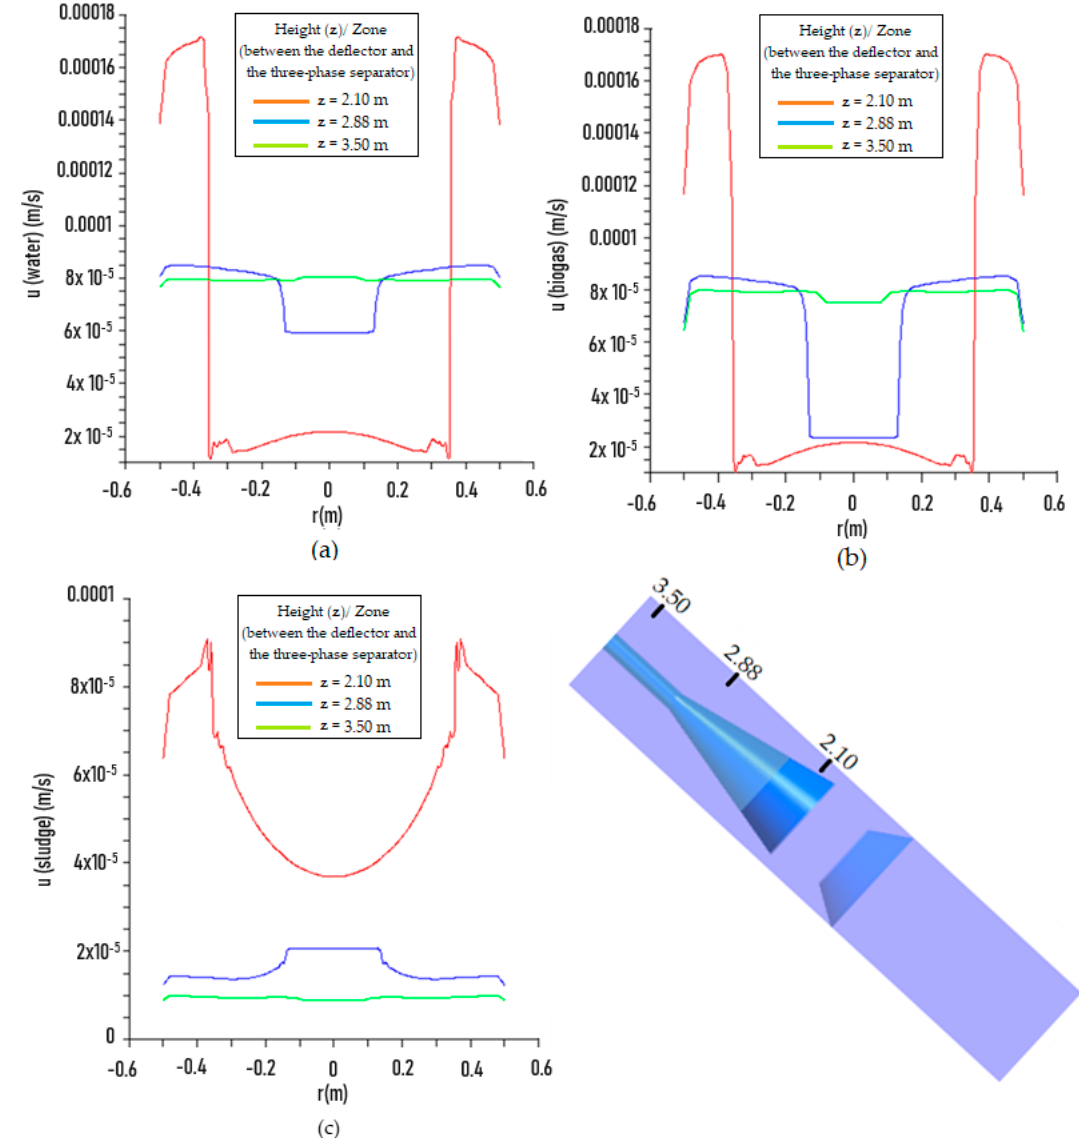
Figure 16. Distribution of the resulting velocity according to the radial position for different axial positions, z, on the three-phase separating region (upward inclination of the deflector): ( a ) water, ( b ) biogas, and ( c ) sludge.